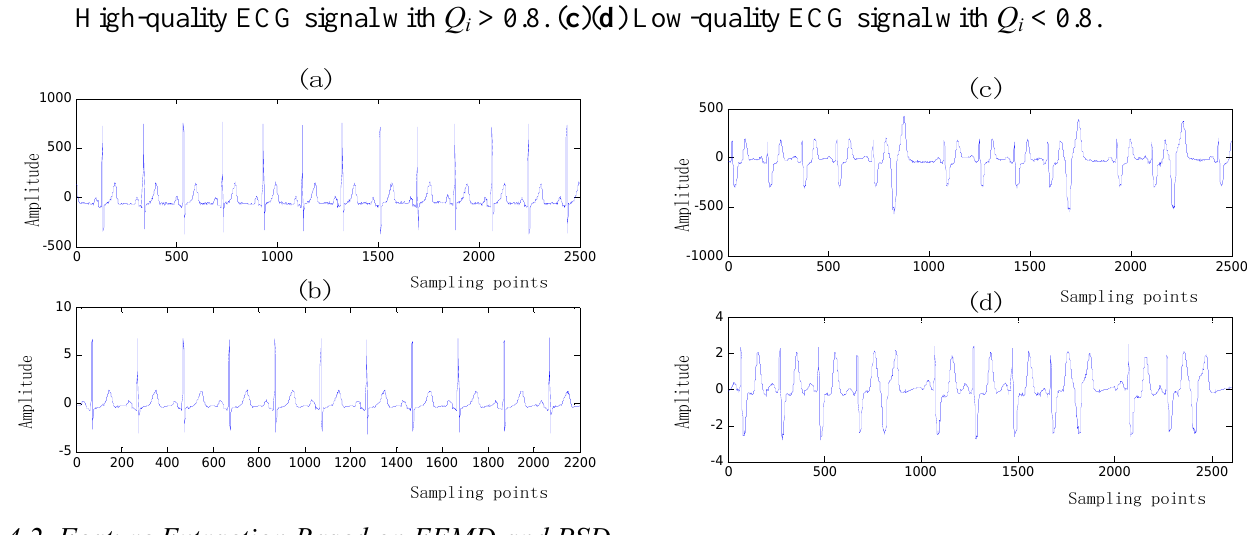
Figure 11. ECG segments from subject in MIT-BIH Arrhythmia database. ( a )( b ) High-quality ECG signal with Q